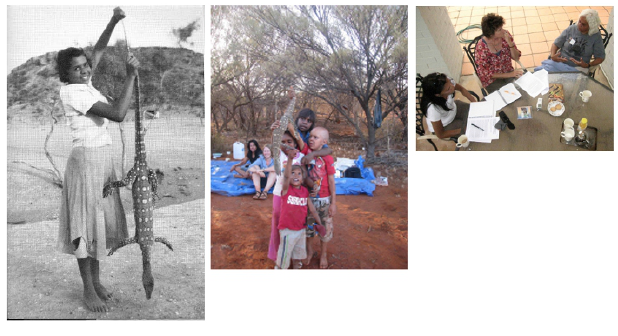
Fig. 3. Arrernte ecological knowledge is acquired through practical experience but nowadays also partially shared in contexts distant from country and its species. (Left) Veronica Dobson with Kere Atyunpe, Varanus giganteus (Perentie) ca. 1960 (from Flynn 1963); (Middle) Josie Douglas (left) with family and friends on a hunting trip in central Arrernte land, the children show Kere Atyunpe hunted by their family, 2008 (Photo by J. Foster); (Right) Three authors prepare this paper during a focus meeting, 2008 (L–R: Josie Douglas, Fiona Walsh, Veronica Dobson) (Photo by H.